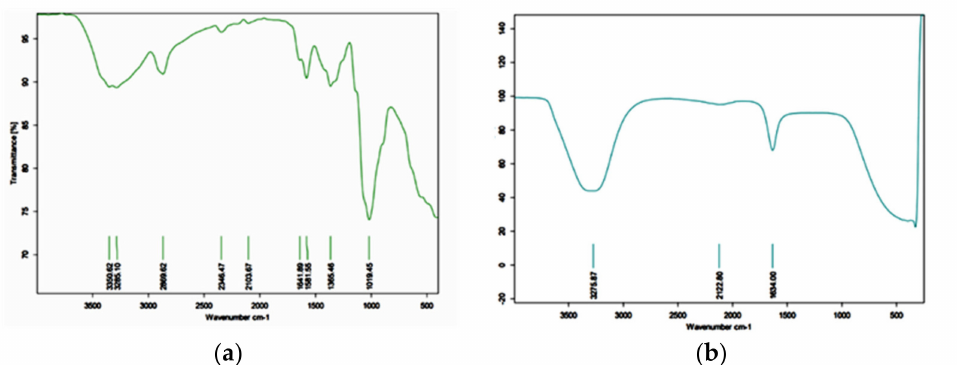
Figure 1. FTIR images of ( a ) WCS; ( b ) WCSNP.